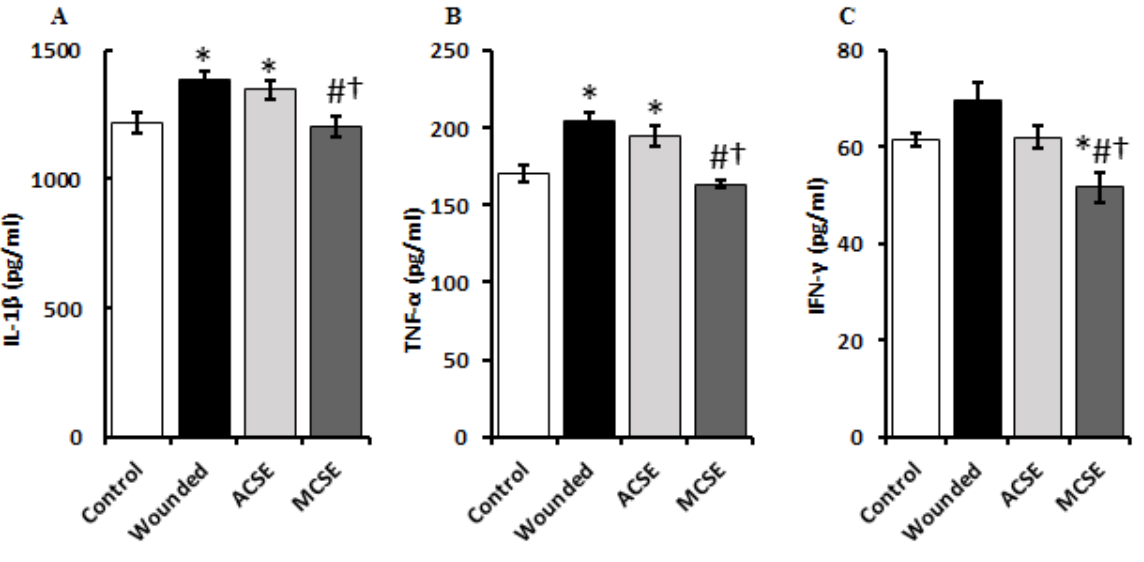
Figure 3: Serum levels of IL-1β, TNF-α, and IFN-γ in wounded rats following treatment with corn silk extracts. ACSE, aqueous corn silk extract; MCSE, methanolic corn silk extract. Bars indicate mean±SEM (n = 5); *, #, and †indicate significant difference at p<0.05 as compared with control, wounded and ACSE